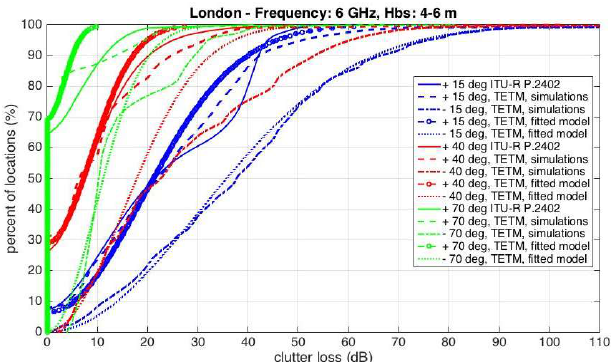
Figure 11. Clutter loss cumulative distributions: comparison between the proposed model and the ITU-R P.2402 model, for elevation angles of 15, 40 and 70 degrees in London (base station height uniformly distributed between 4 and 6 m).